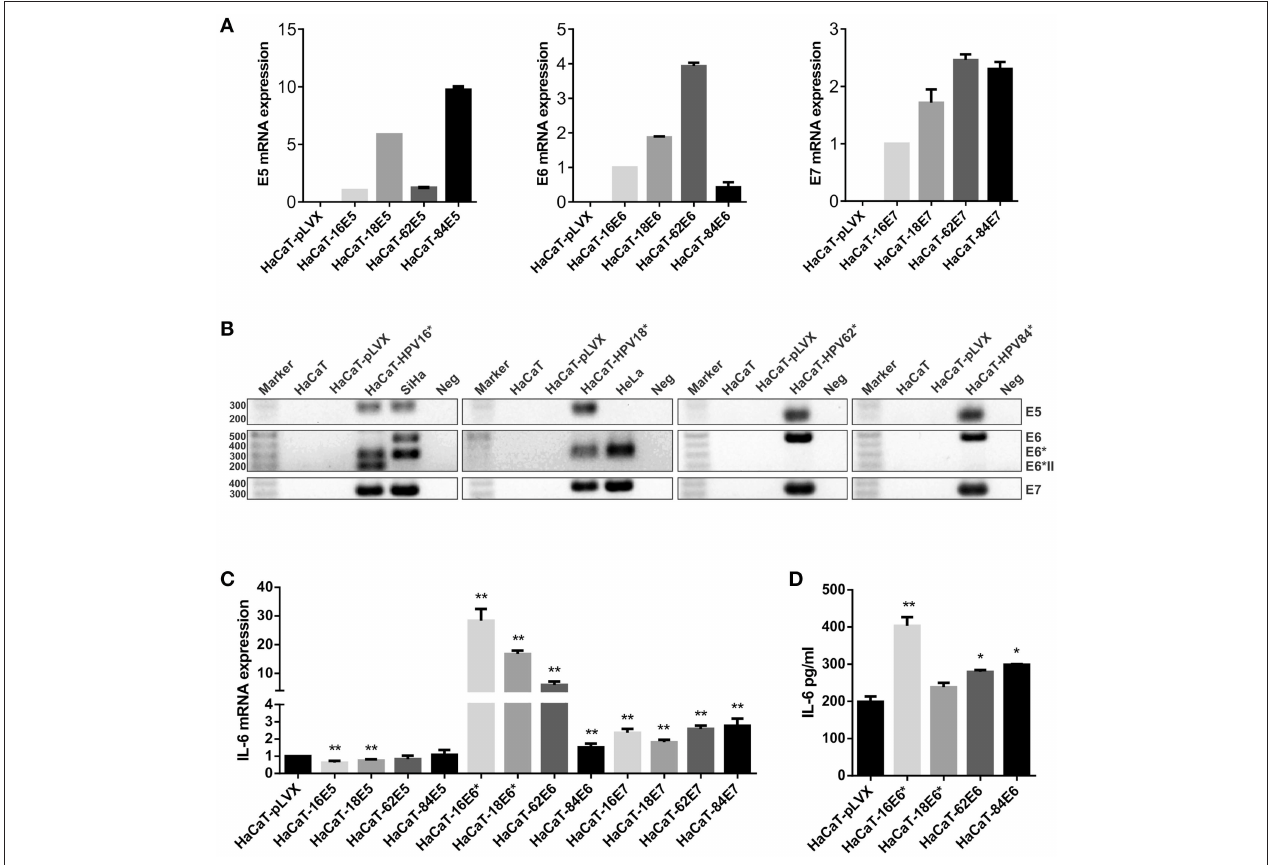
FIGURE 2 | Evaluation of IL-6 expression in E5-, E6-, and E7-transduced HaCaT keratinocytes. (A) E5, E6, and E7 expression measured by qPCR in HaCaT transduced cell lines using HaCaT-16E5, HaCaT-16E6, and HaCaT-16E7 as calibrators and actin as reference gene. (B) Visualization of E5, E6, E7, and E6 isoforms mRNAs expressed in transduced HaCaT cell lines, HeLa, and SiHa cells. (*) HaCaT-16, HaCaT-18, HaCaT-62, and HaCaT-84 refer to HaCaT cells transduced with one of the 3 genes E5, E6, or E7 separately to check E5, E6, and E7 expression, respectively. The expected amplicon size for each viral gene is indicated in Table S1 . Water was used as template in the negative controls (Neg). (C) IL-6 mRNA expression evaluated by qPCR in E5, E6, or E7 from HPV16, 18, 62, or 84 transduced HaCaT cells, using HaCaT-pLVX cells as calibrator and actin, RPLP0, and RPL32 as reference genes. (D) Protein levels of IL-6 measured by ELISA test in HaCaT-pLVX and HaCaT-E6 supernatants. Asterisks indicate statistical significance (* p < 0.05 and ** p <